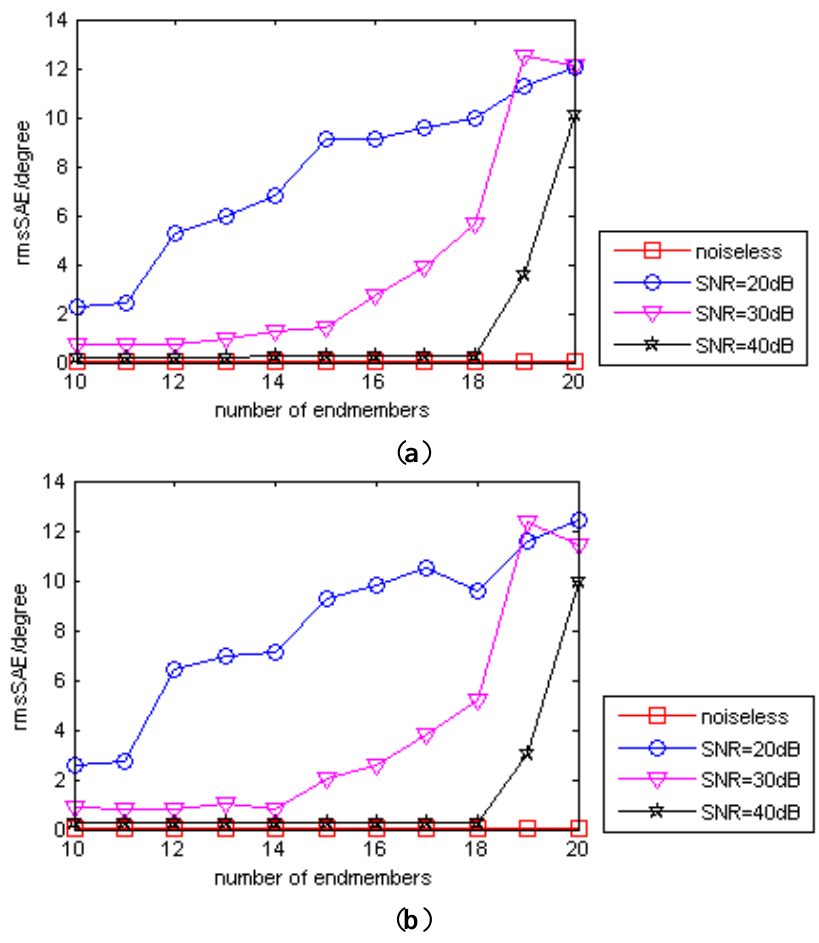
Figure 11. The rmsSAE of the proposed method as a function of the number of endmembers under different noise levels. ( a ) Compression ratio 𝑡 = 10; ( b ) Compression ratio 𝑡 =